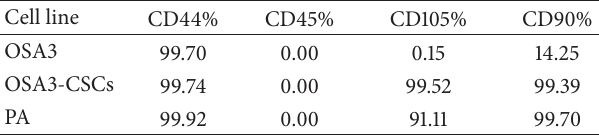
Table 2: Expression of CD44, CD45, CD105, and CD90 in OSA3, OSA3-CSCs, and PA lines determined by flow cytometry (percent- age of cells expressing the